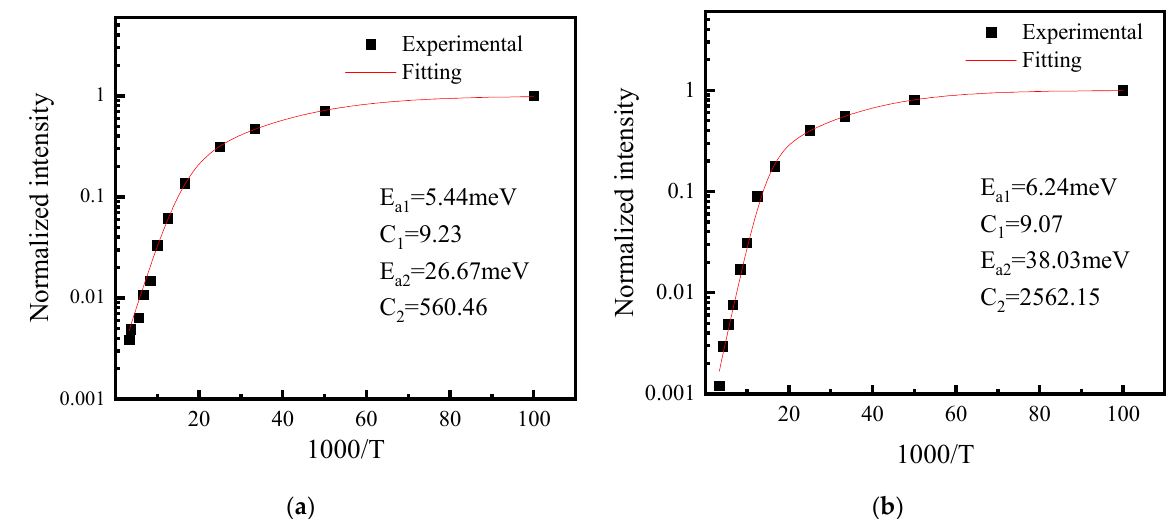
Figure 8. Variation of the normalized integrated PL intensity with the reciprocal temperature for extended wavelength InGaAs on InP substrate. The red solid lines represent the Arrhenius fitting results: ( a ) sample A; ( b ) sample B.